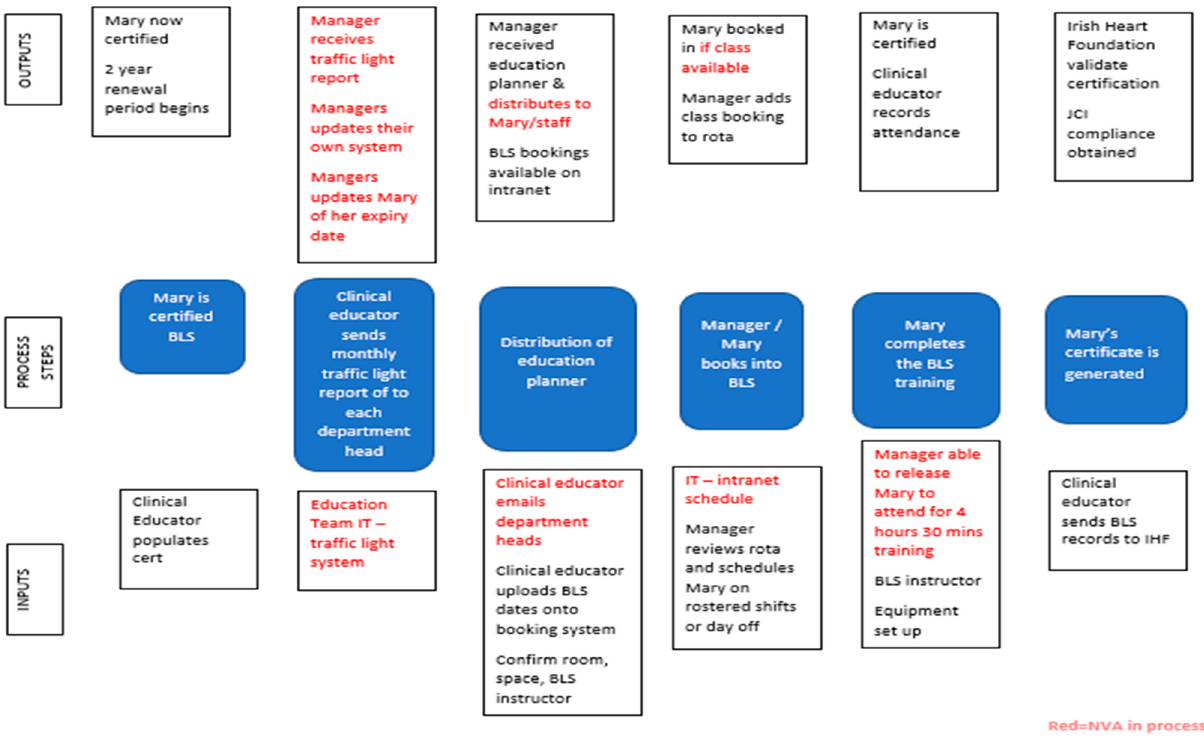
Figure 1. IPO Map.